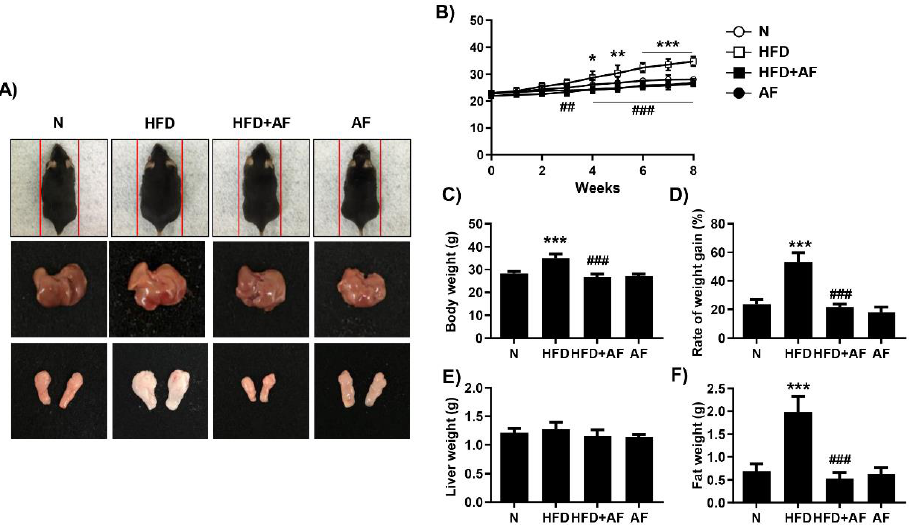
Figure 1. Auranofin attenuates body weight gain and the epididymal fat pad in the high-fat diet (HFD)-induced non-alcoholic fatty liver disease (NAFLD) mouse model. Animals were fed a 60% HFD (60% of calories from fat) and/or a regular diet and also received intraperitoneal injection of auranofin (10 mg/kg) and/or normal saline for 8 weeks. ( A ) Representative photographic images of the whole mouse body, liver, and epididymal fat pad specimens in each group. ( B ) Body weight gain for 8 weeks. Data are expressed as the mean ± SD ( n = 10). * p < 0.05, ** p < 0.01, and *** p < 0.001 compared with the normal group. ## p < 0.01 and ### p < 0.001 compared with HFD group. ( C – F ) The average values for body weight, rate of weight gain, liver and epididymal fat pad after the study period. Data are expressed as the mean ± SD ( n = 8). *** p < 0.001 compared with the normal group. ### p < 0.001 compared with HFD group. N, normal group; HFD, HFD fed group; HFD + AF, HFD fed and auranofin injection group; AF, auranofin injection group.